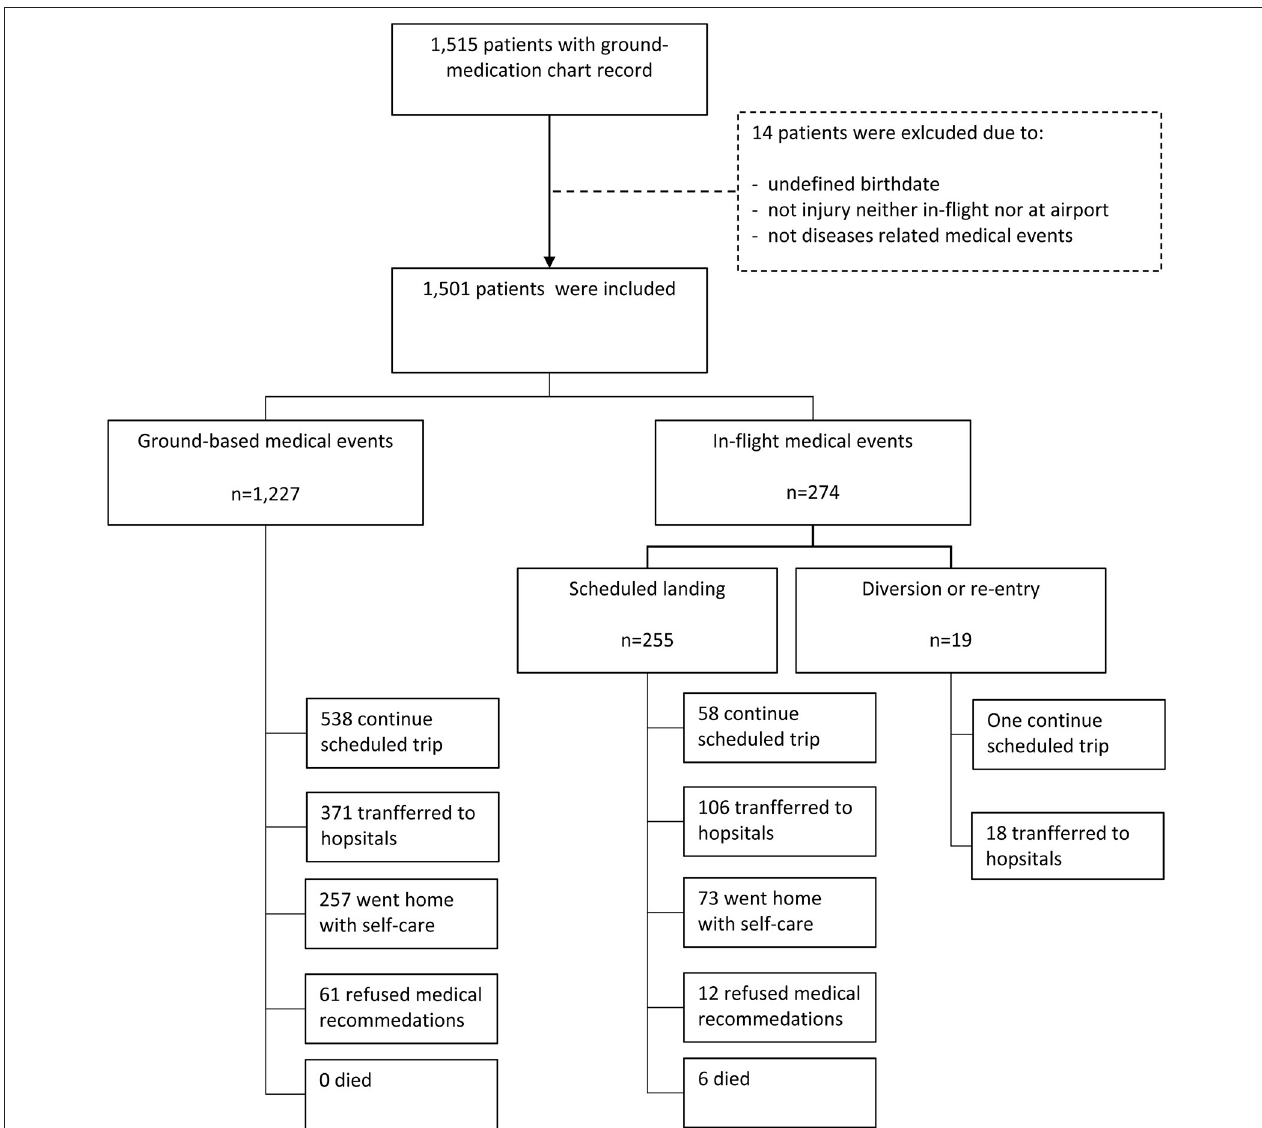
FIGURE 1 | Flow-chart of patient